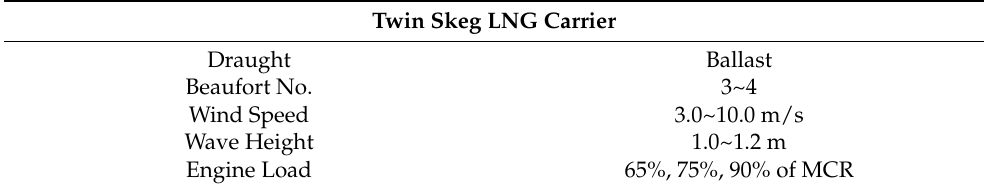
Table 4. Overview of the speed trials of the twin skeg LNG carrier.